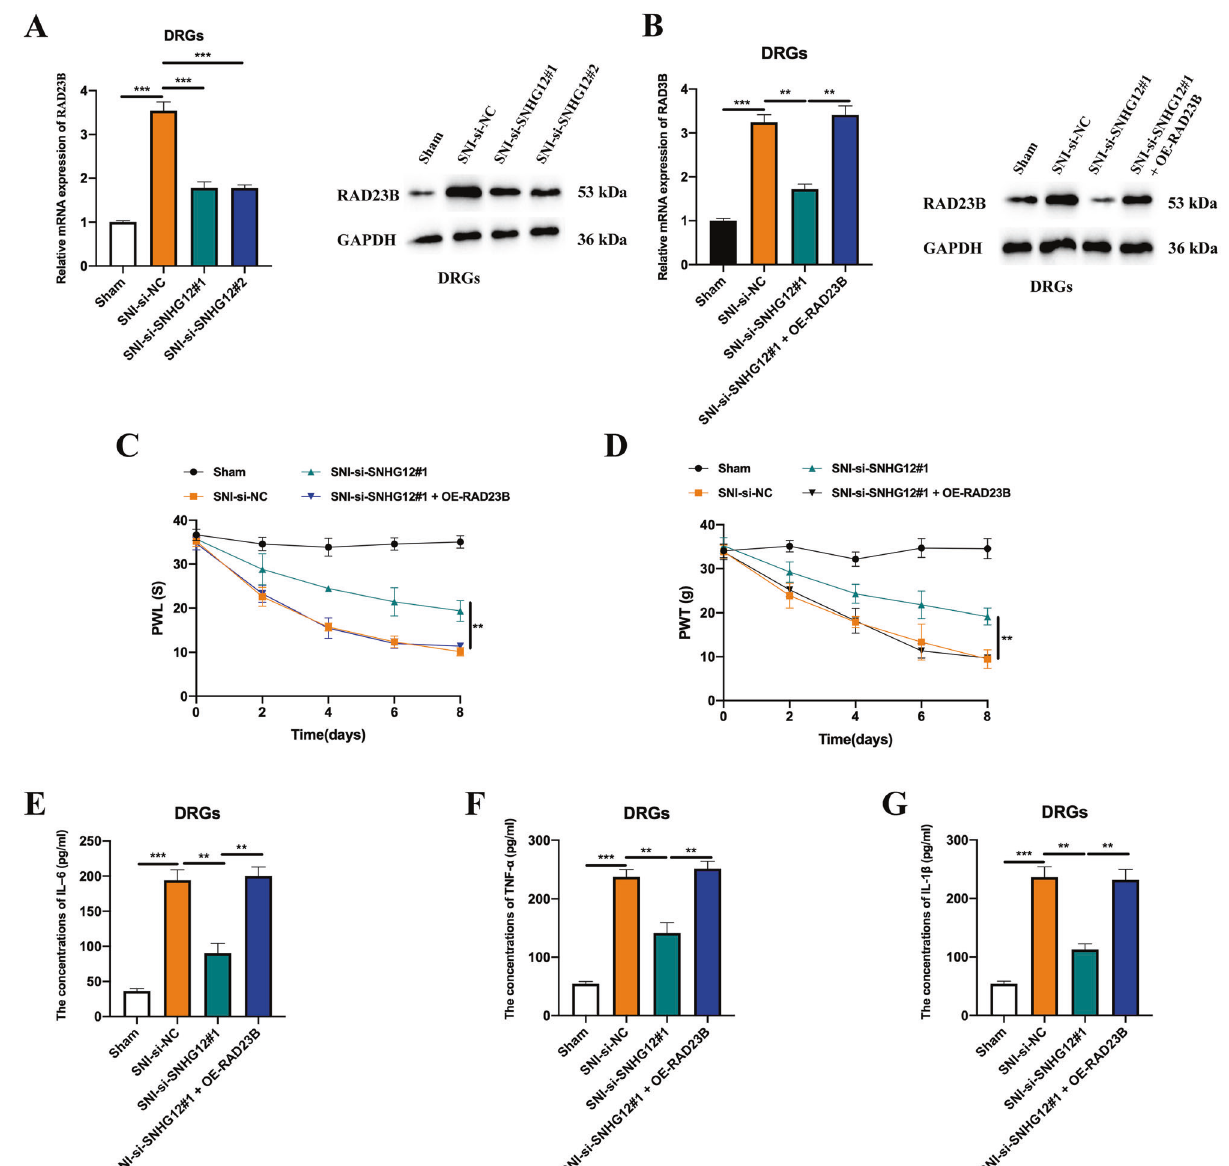
Fig. 7 LncRNA SNHG12 plays a functional role in SNI-induced neuropathic pain through the miR-494-3p/RAD23B axis. A The mRNA and protein levels of RAD23B in the DRGs from SNI rats pre-intrathecally injected with si-NC, si-SNHG12#1, and si-SNHG12#2. B The mRNA and protein expression levels of RAD23B in the DRGs from SNI rats pre-intrathecally injected with si-NC, si-SNHG12#1, and si-SNHG12#1 + OE- RAD23B. C PWL or ( D ) PWT assays were performed to assess the neuropathic pain of rats from the sham and pre-treated SNI groups. The levels of IL – 6 ( E ), TNF – α ( F ), and IL-1 β ( G ) in the DRGs of rats from the sham and the pre-treated SNI groups were assessed by ELISA. Experimental data are presented as mean ± SD. ** P < 0.01, *** P <